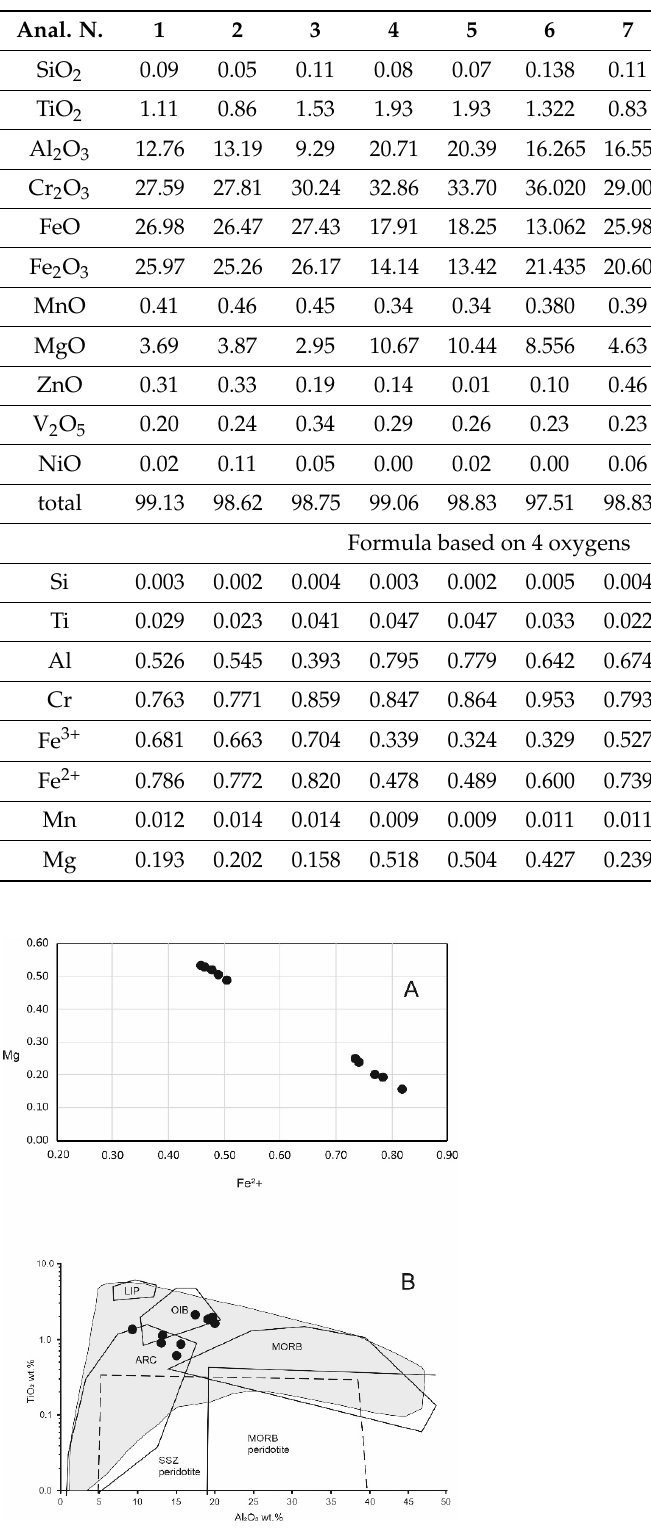
Figure 8. ( A ) Mg vs. Fe 2+ plot; ( B ) TiO 2 versus Al 2 O 3 plot for studied spinels. Large Igneous Province (LIP), Ocean Island Basalts (OIB), Island Arc magmas (ARC), Mid Ocean Ridge Basalts (MORB), volcanic rocks (grey field), Suprasubduction Zone (SSZ), MORB and peridotite fields after Lenaz et al. [54] and Kamenetsky et al. [55].